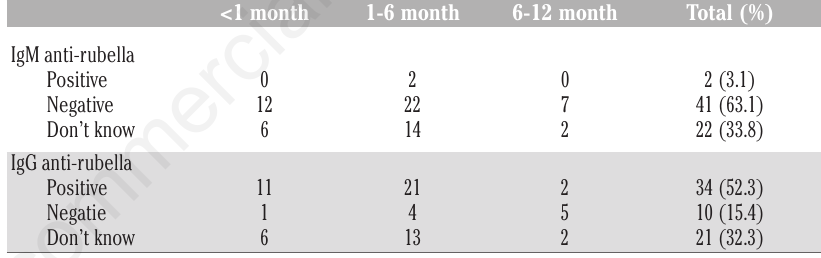
Table 2. Anti-rubella IgM and IgG test results.